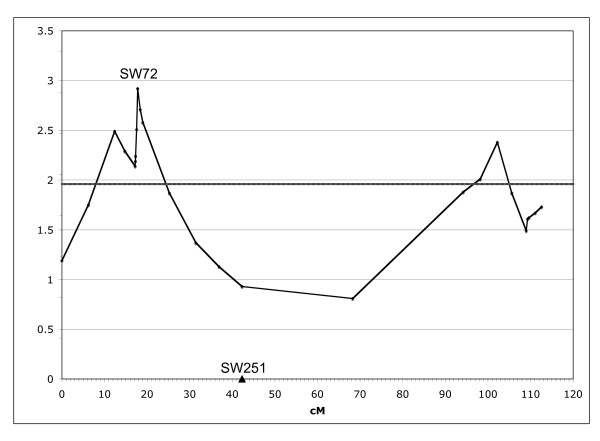
Plot of NPL scores of multipoint linkage analysis on SSC3. Plot of NPL scores using 13 microsatellites located on SSC3. The grey line indicates the significance limit of 1.96. With the multipoint algorithm additional points are calculated in the middle between the markers, therefore, the 26 data points shown in the graph correspond to 13 microsatellite markers tested. GUSB is localized between SW72 and SW251 as confirmed by radiation hybrid panel analyses. SW251 was not used in the genome wide linkage scan, but is indicated as rectangular on the x-axis.